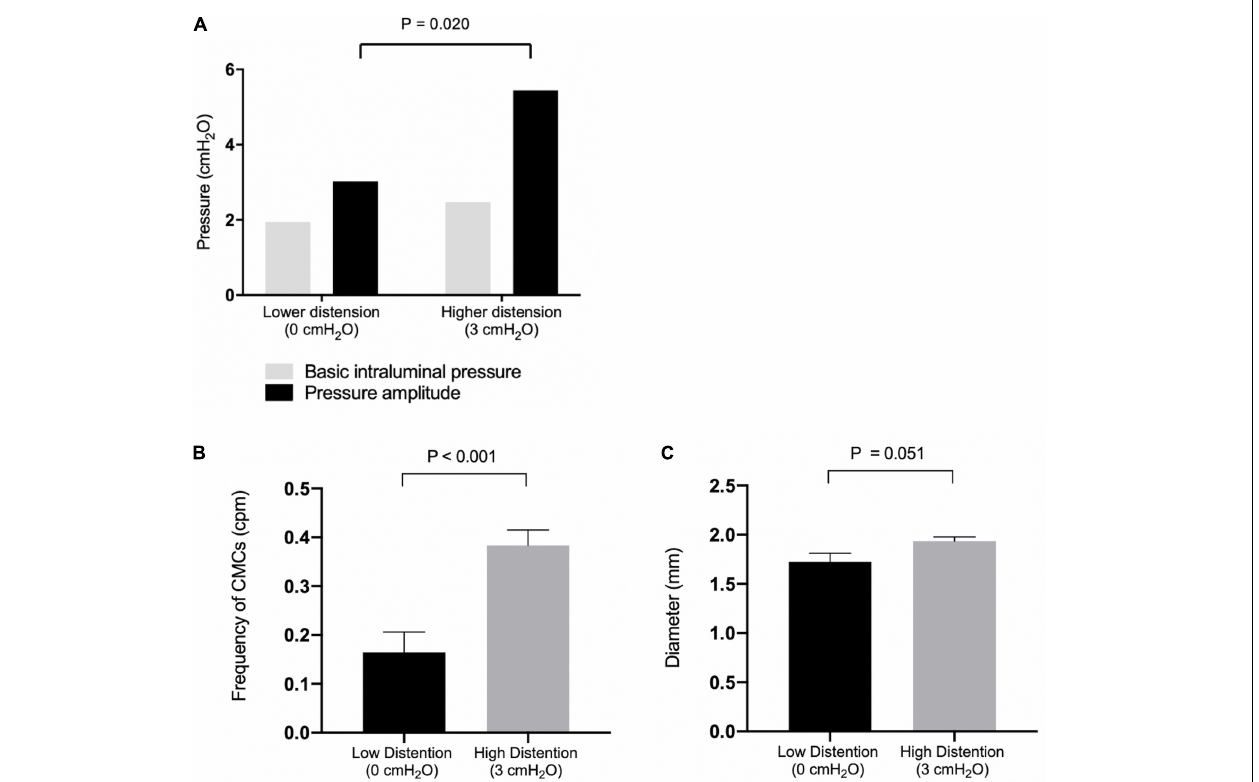
FIGURE 4 | (A) Basic intraluminal pressure and pressure amplitudes of observed CMCs under low and high distention. Compared with 0 cmH 2 O ( N = 7), 3 cmH 2 O ( N = 5) of outflow pressure increased the pressure amplitude of CMCs observed ( P = 0.020). (B) CMC frequencies under low and high distention. Compared with 0 cmH 2 O ( N = 10), 3 cmH 2 O ( N = 7) of outflow pressure increased the frequency of CMCs in the colon ( P < 0.001. (C) Colonic diameter under low ( N = 9) and high distention ( N = 7). P values were determined by Student’s T